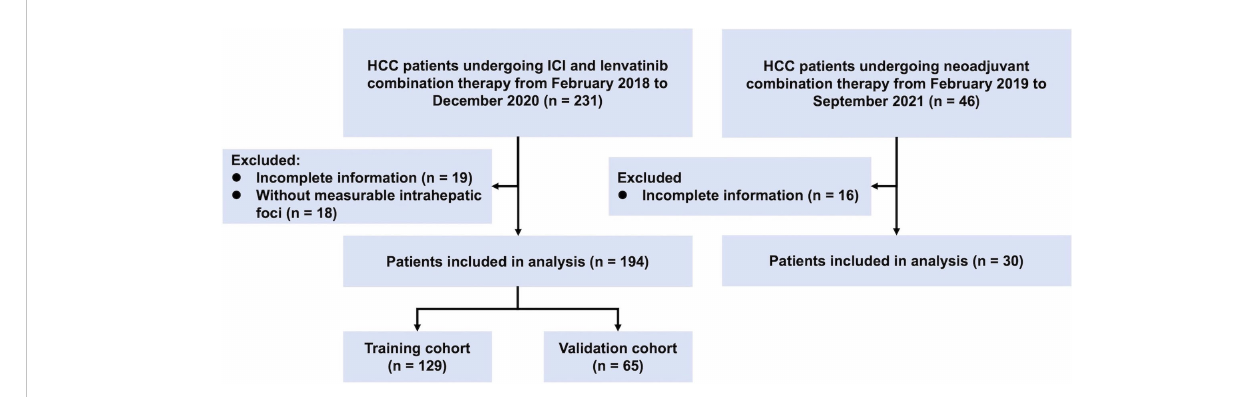
FIGURE 1 Flowchart of the recruitment pathway for patients. HCC, hepatocellular carcinoma; ICI, immune checkpoint inhibitor.